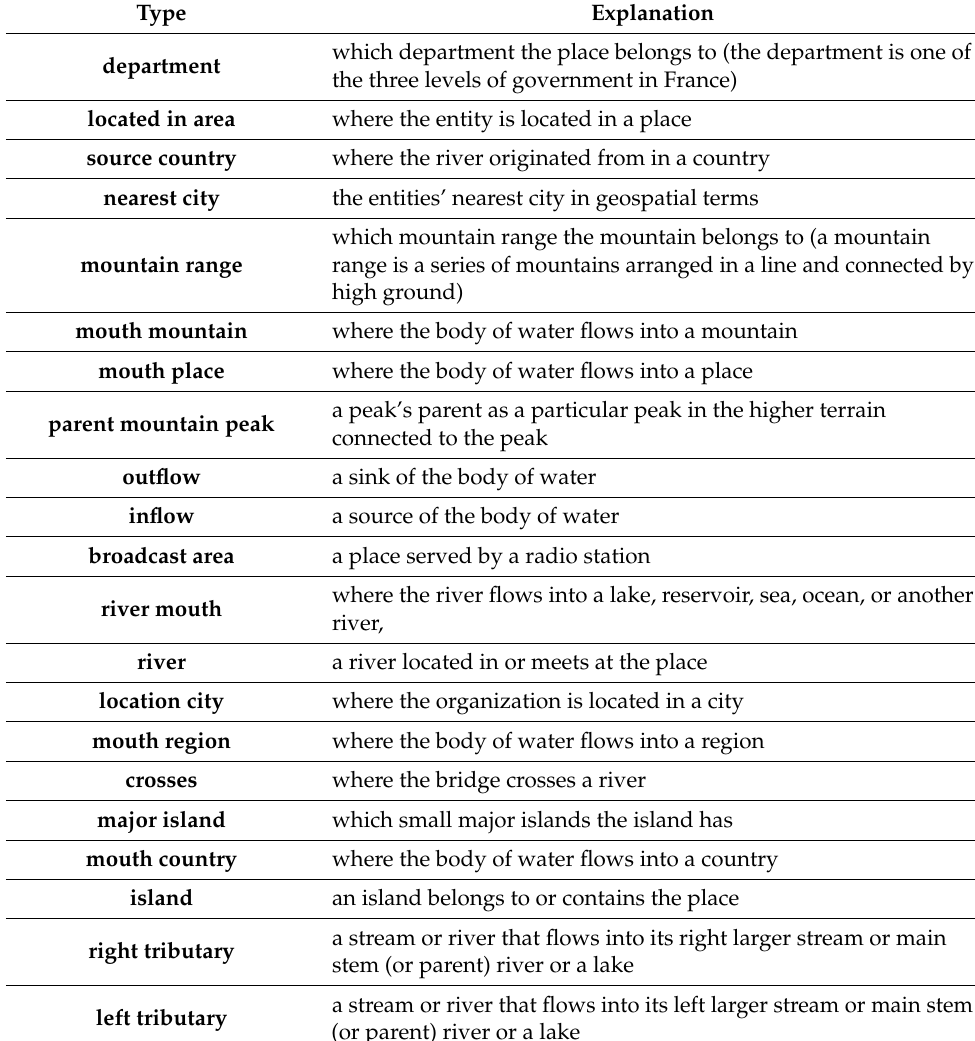
Table 5. Explanation of relationship types in the GeoDBpedia21